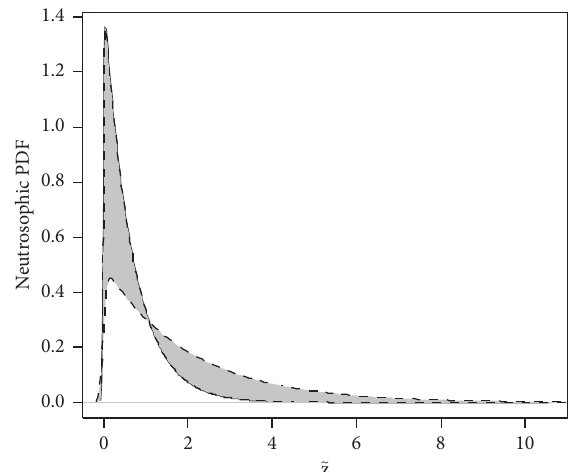
Figure 1: The sturdy curve of exponential distribution.